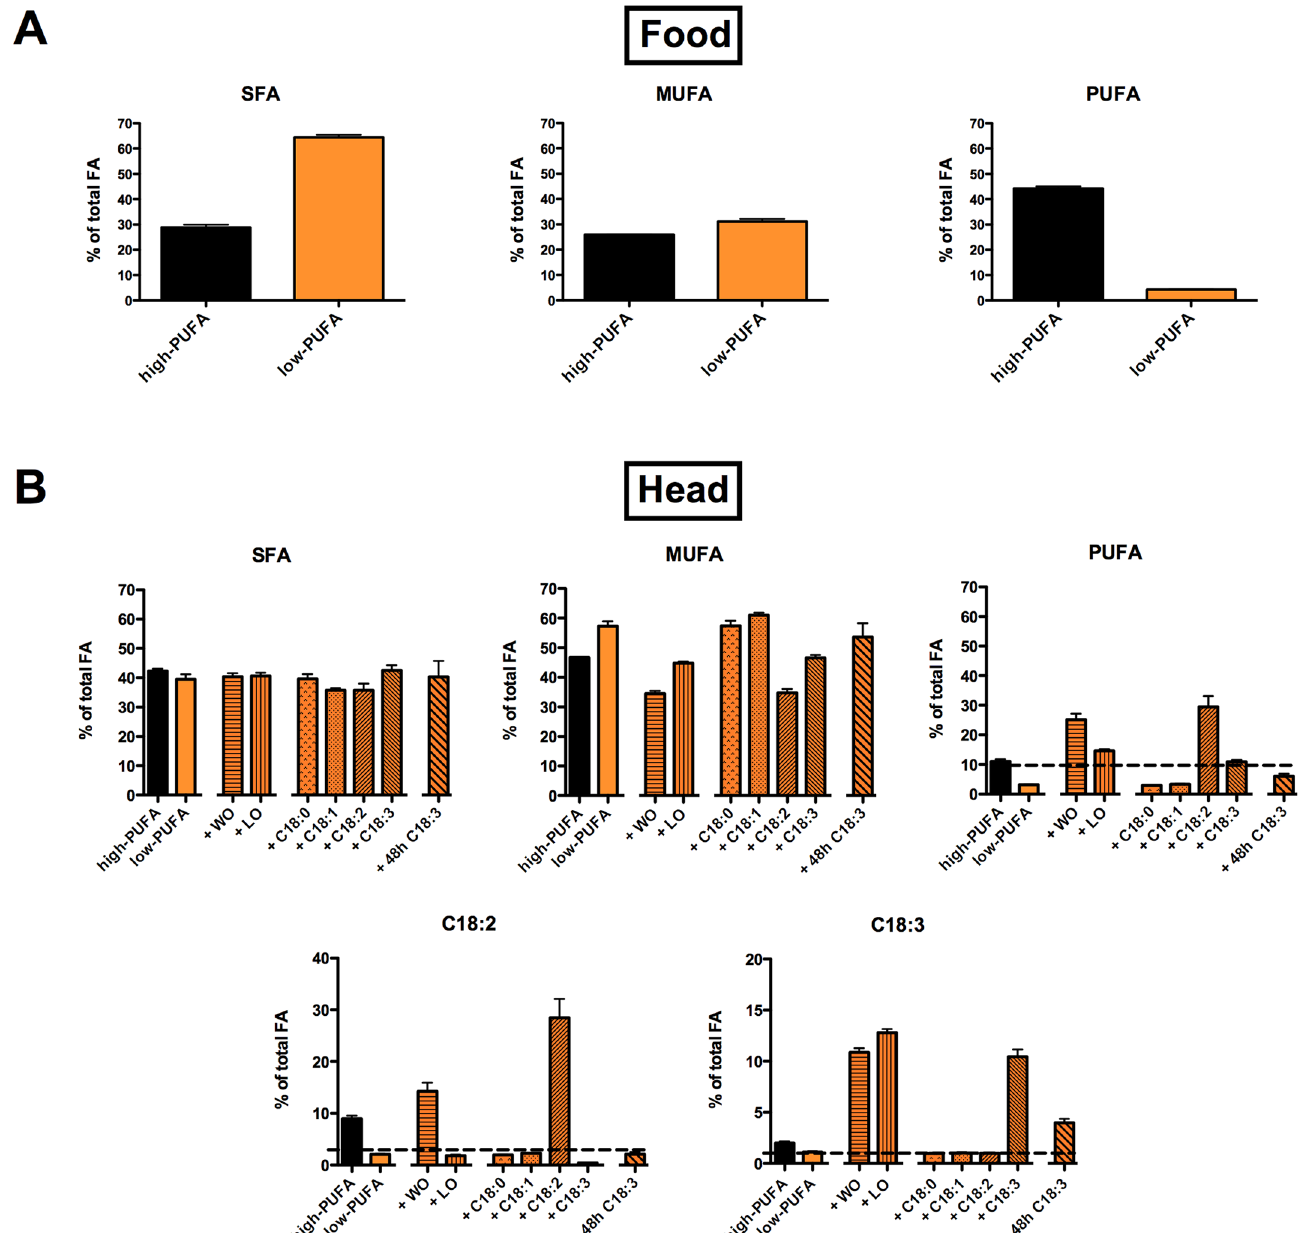
Fig 1. Fatty acid contents in fly food and fly heads. (A) relative amounts of saturated fatty acids (SFA), mono-unsaturated fatty acids (MUFA), and poly- unsaturated fatty acids (PUFA) in two Drosophila diets (high-PUFA diet in black, low-PUFA diet in orange) (N = 4). (B) relative amounts of SFA, MUFA, and PUFA in Drosophila heads (N = 3 groups of 30 heads). FA contents are indicated in black when flies were raised on a high-PUFA diet or orange when flies were raised on a low-PUFA diet. Bars in orange and black indicate that flies were raised on low-PUFA diet enriched with walnut oil (WO) or linseed oil (LO), which both contain non-essential and essential FA, single non-essential fatty acid (C18:0 or C18:1) or single essential fatty acids (C18:2 or C18:3). The orange and black diagonally striped bar on the very right indicates FA contents of fly heads when animals were raised on a low-PUFA diet and then were fed with a low-PUFA diet enriched in C18:3 for 48 hours during their adulthood. A complete FA analysis and absolute values can be observed in SF1, SF2, and ST2. Data in B represent mean ±